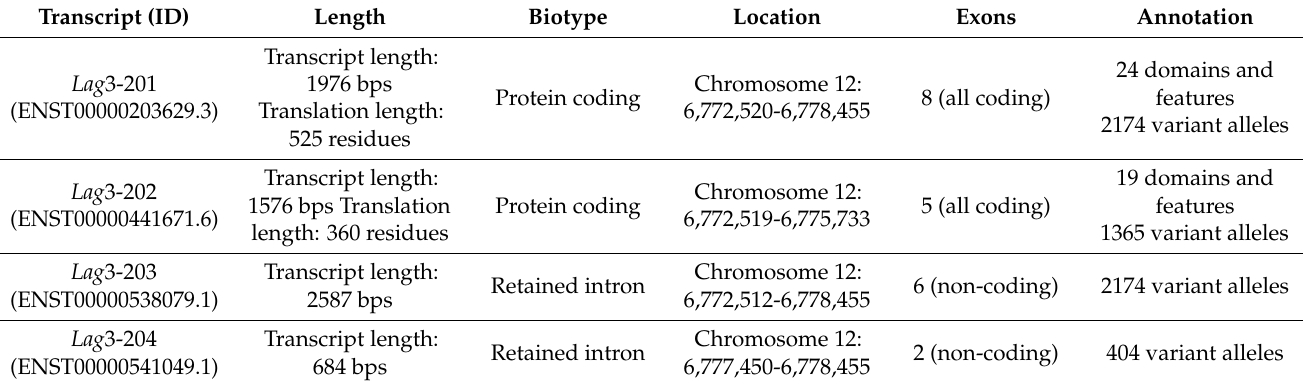
Table 1. Characterization of human LAG-3 transcripts as listed in ENSEMBLE (https://www.ensembl.org/index.html; accessed on 2 May 2021) [62].